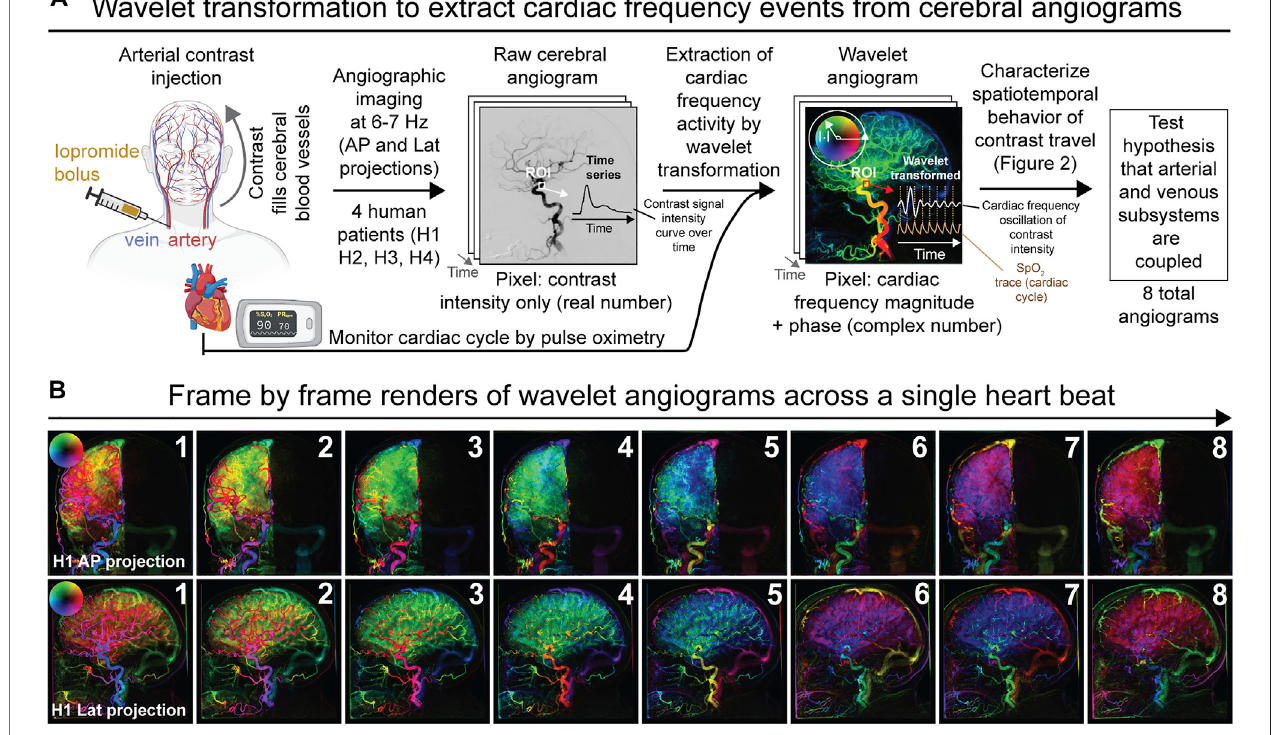
FIGURE 1 | Overview of experimental and analytical approach to analyze diagnostic cerebral angiograms by wavelet transformation. (A) Schematic depicting the derivation of wavelet angiograms from raw cerebral angiograms acquired in neurologically unremarkable human patients. In summary, the wavelet transformation permits extraction of contrast intensity signals that oscillate at cardiac frequency from the raw cerebral angiograms. Analysis of the wavelet transformed data from different anatomical components of the cerebrovascular network allowed us to test the hypothesis that the arterial and venous subsystems are coupled. (B) Wavelet transformed right common carotid angiogram during the duration of a single heartbeat demonstrating multiple spatiotemporal phase groupings for subject H1 (frame rate 6.0 Hz). Both anterior-posterior (AP) and lateral (lat) projections are shown.